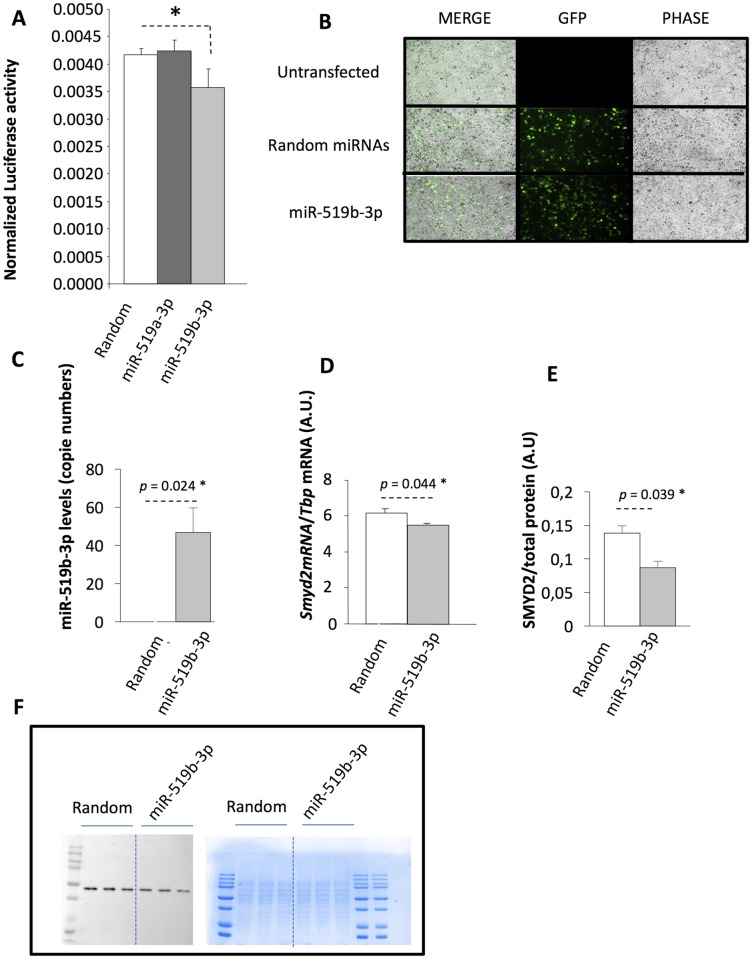
Validation of Smyd2 mRNA interaction with miR-519.A) HEK293T cells were transfected with reporter plasmid containing the 3’-UTR region of Smyd2 associated with luciferase/renilla and with either a plasmid expressing random miRNAs, or pre-miR-519a-3p or pre-miR-519b-3p. B) Transfection efficiency with miR-519b-3p was validated by visualizing GFP in HEK293T and was found similar to the efficiency with random miRNAs. C) Validation of miR-519b-3p overexpression in HEK293T. D) Quantification of Smyd2 mRNA level in HEK293T transfected a plasmid containing either pre-miR-519-3p or random miRNA sequences. E) Quantification of SMYD2 protein level in HEK293T transfected with either pre-miR-519-3p or random miRNA sequences. F) Western-blot of HEK293T protein extract, transfected either with pre-miR-519-3p or random miRNA sequences. Left, after blotting with anti-SMYD2 antibodies, right, acrylamide gel revealed with coomassie blue to validate that the quantity of protein loaded was the same for each sample.